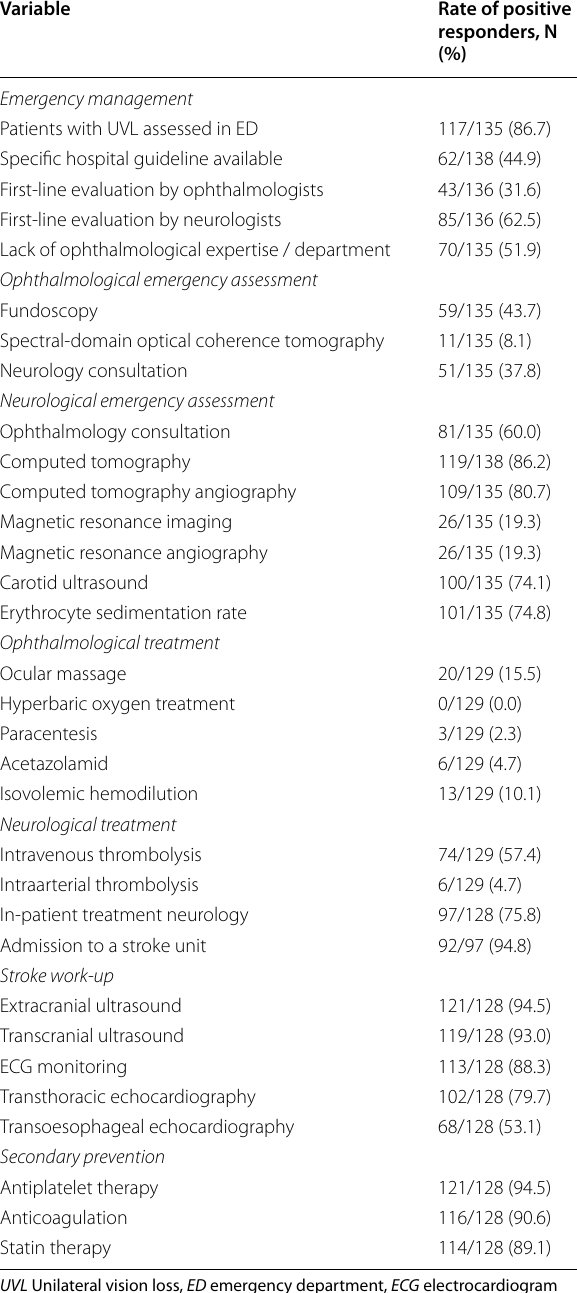
Table 2 Details of diagnostic procedures and treatment